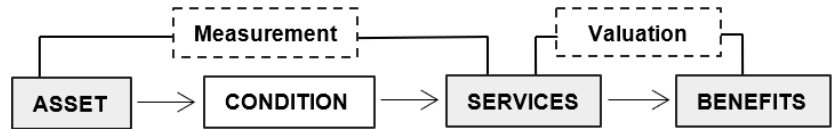
Figure 1. Flowchart adapted from the Natural Capital Protocol [21] illustrating the relationship between a natural capital asset , the condition of that asset, the ecosystem services that flow from the asset, and the benefits that those services provide to people.